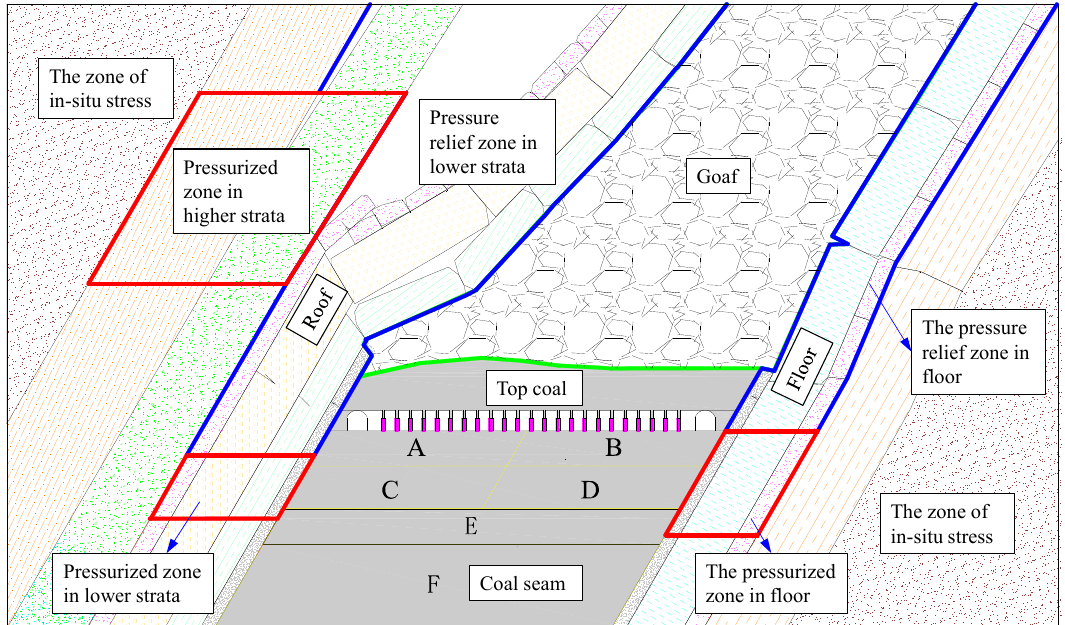
Figure 11. Distribution of stress in coal and rock along the inclination of the working face.